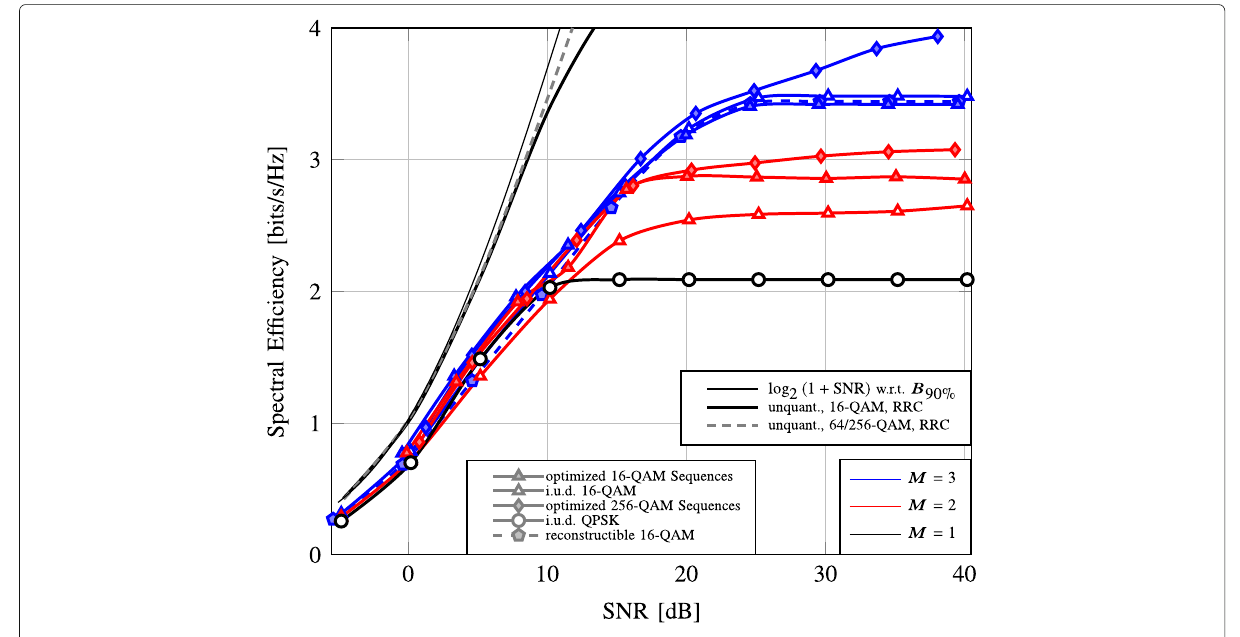
Fig. 12 Spectral efficiency ( B 90% ) versus SNR considering QAM transmit symbols